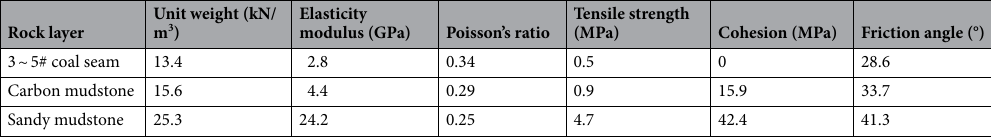
Table 2. Particle mechanical parameters of coal and roof rock